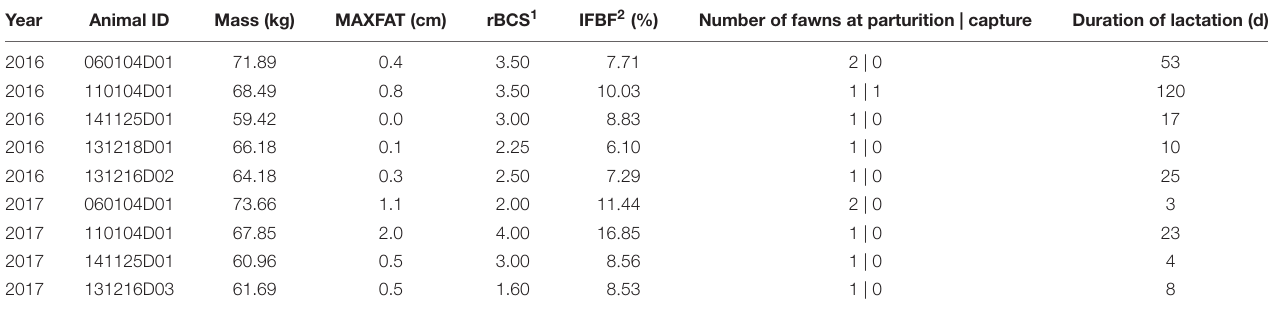
MAXFAT (cm) rBCS 1 IFBF 2 (%) Number of fawns at parturition | capture Duration of lactation